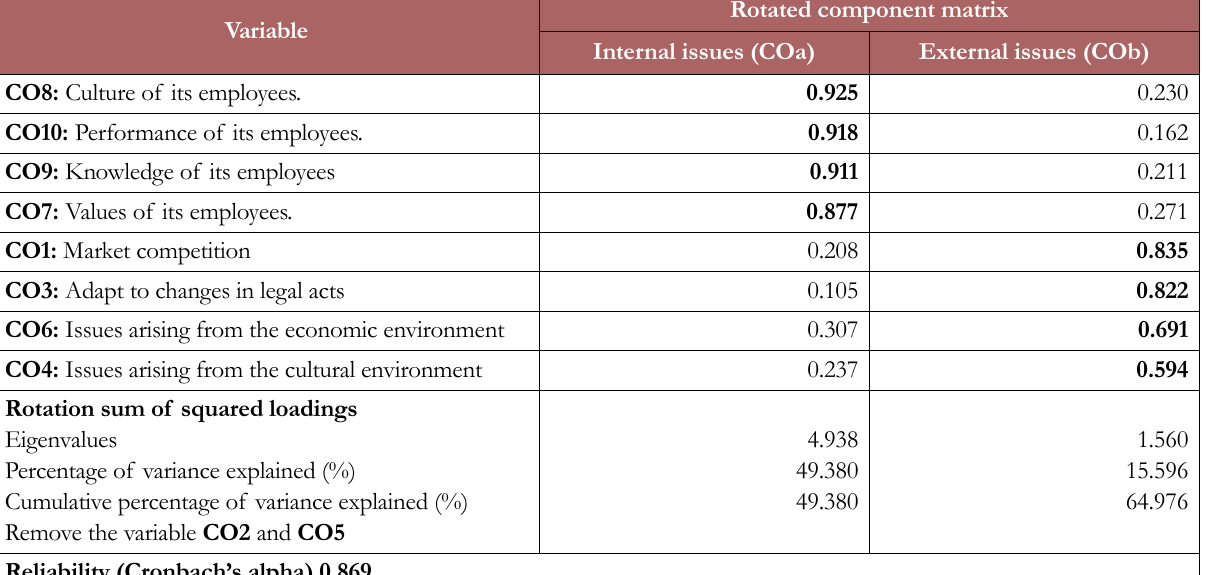
Table 4. EFA of the CO